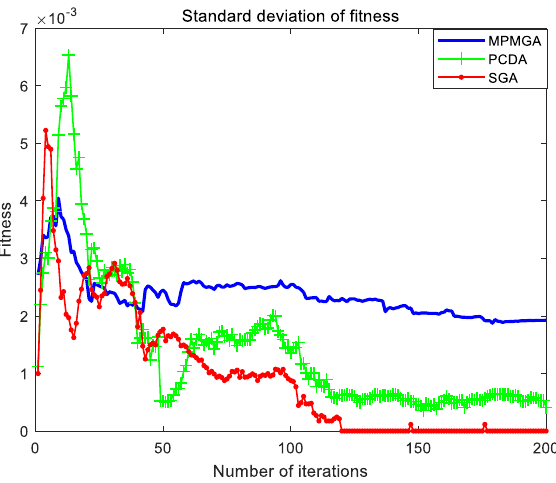
Figure 16. Evolutionary comparison diagram of population fitness standard deviation.